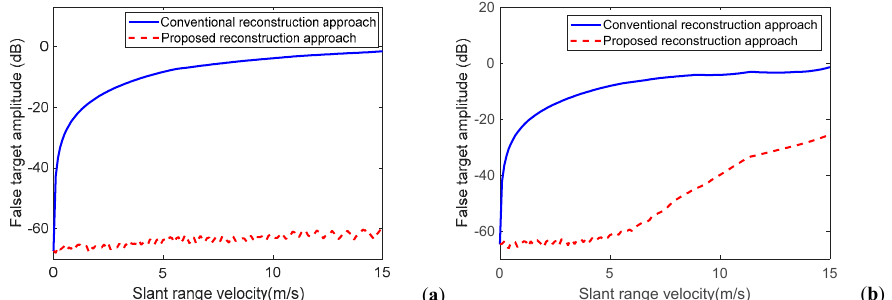
Figure 17. The relationship between the maximum false target amplitude with the different slant range velocities. ( a ) The azimuth band-limited case. ( b ) The azimuth non-band-limited